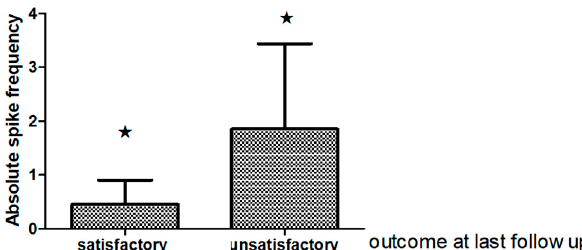
Figure 3. Bar grah showing comparisons of absolute spike frequency on the EEG one year postsurgery (mean and standart deviation SD) in temporal lobe patients with satisfactory (Engel class I) and unsatisfactory (Engel class II–IV) outcome at the last follow up (6–14 years) ( ★ p < 0.05, Mann Whitney U test).